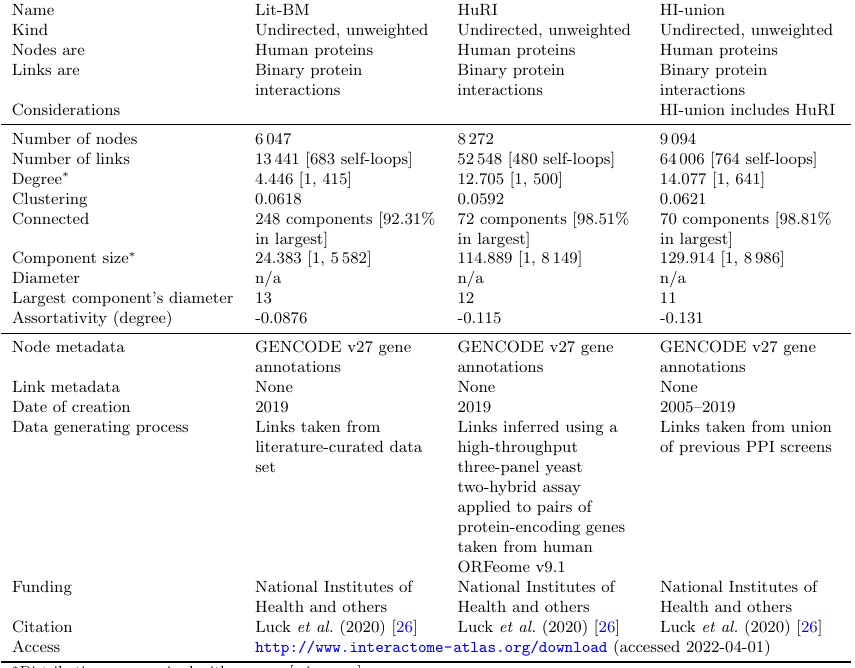
Table 6 A network “multicard”. Here the HuRI network (Table) is compared against two other networks from the same study (Luck et al.